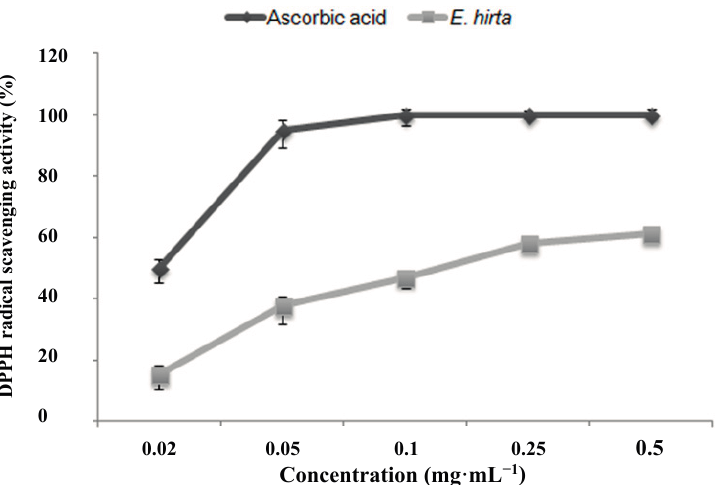
Figure 2. DPPH radical scavenging activity of the ethanol extract of E. hirta . Values are the average of triplicate experiments and represented as mean ±